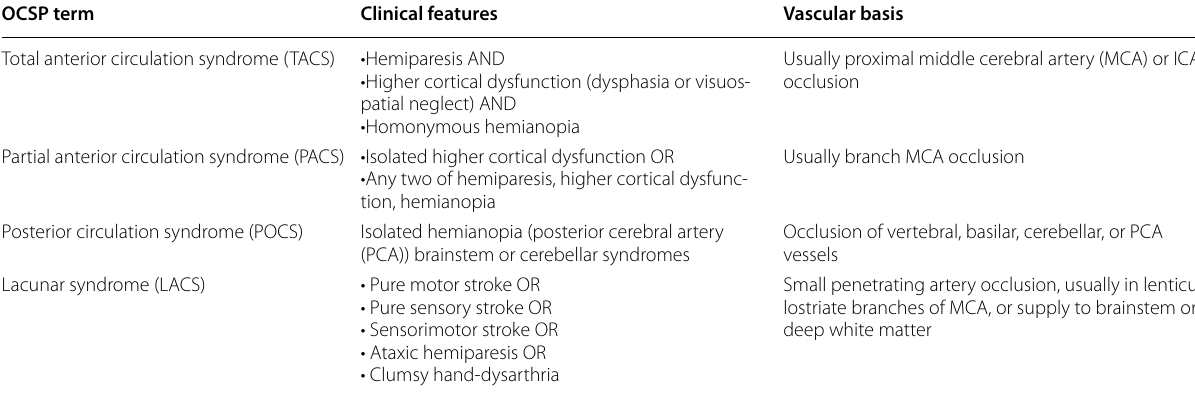
Table 1 Oxfordshire Community Stroke Project